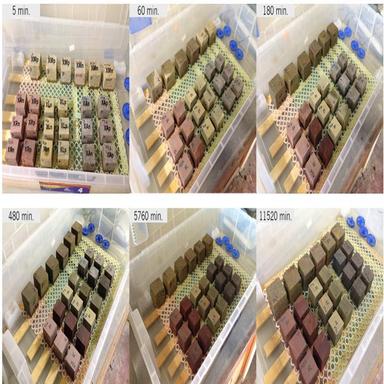
Water absorption by capillary testing on schists.